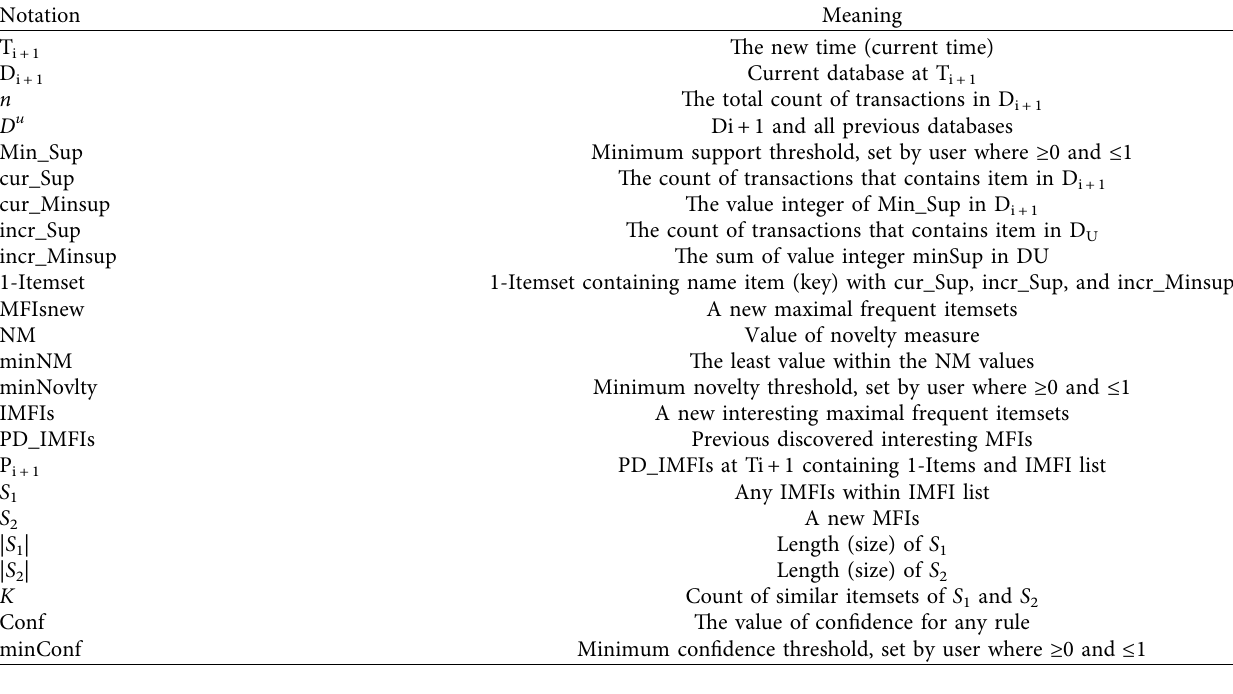
Table 2: Notation and meaning.